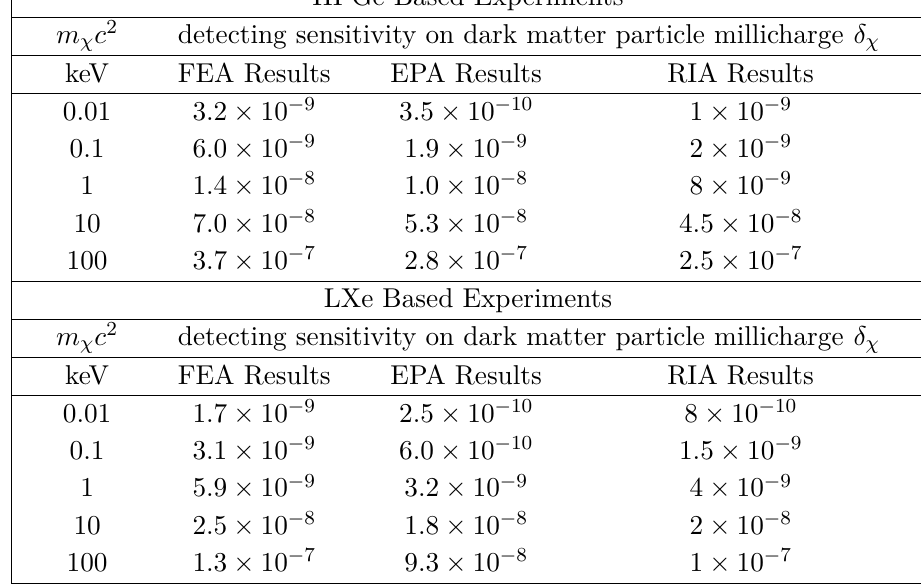
Table 1 . Estimation of detecting sensitivity on dark matter particle millicharge δ χ in the next- generation direct detection experiments. The results for HPGe and LXe based experiments in the FEA, EPA and RIA calculations are given in this table. In the HPGe based next-generation experiments, the energy threshold and background level have been assumed as 100 eV and 0.1 cpkkd, respectively. While in the LXe based next-generation experiments, the energy threshold and background level are assumed as 500 eV and 10 − 4 cpkkd,